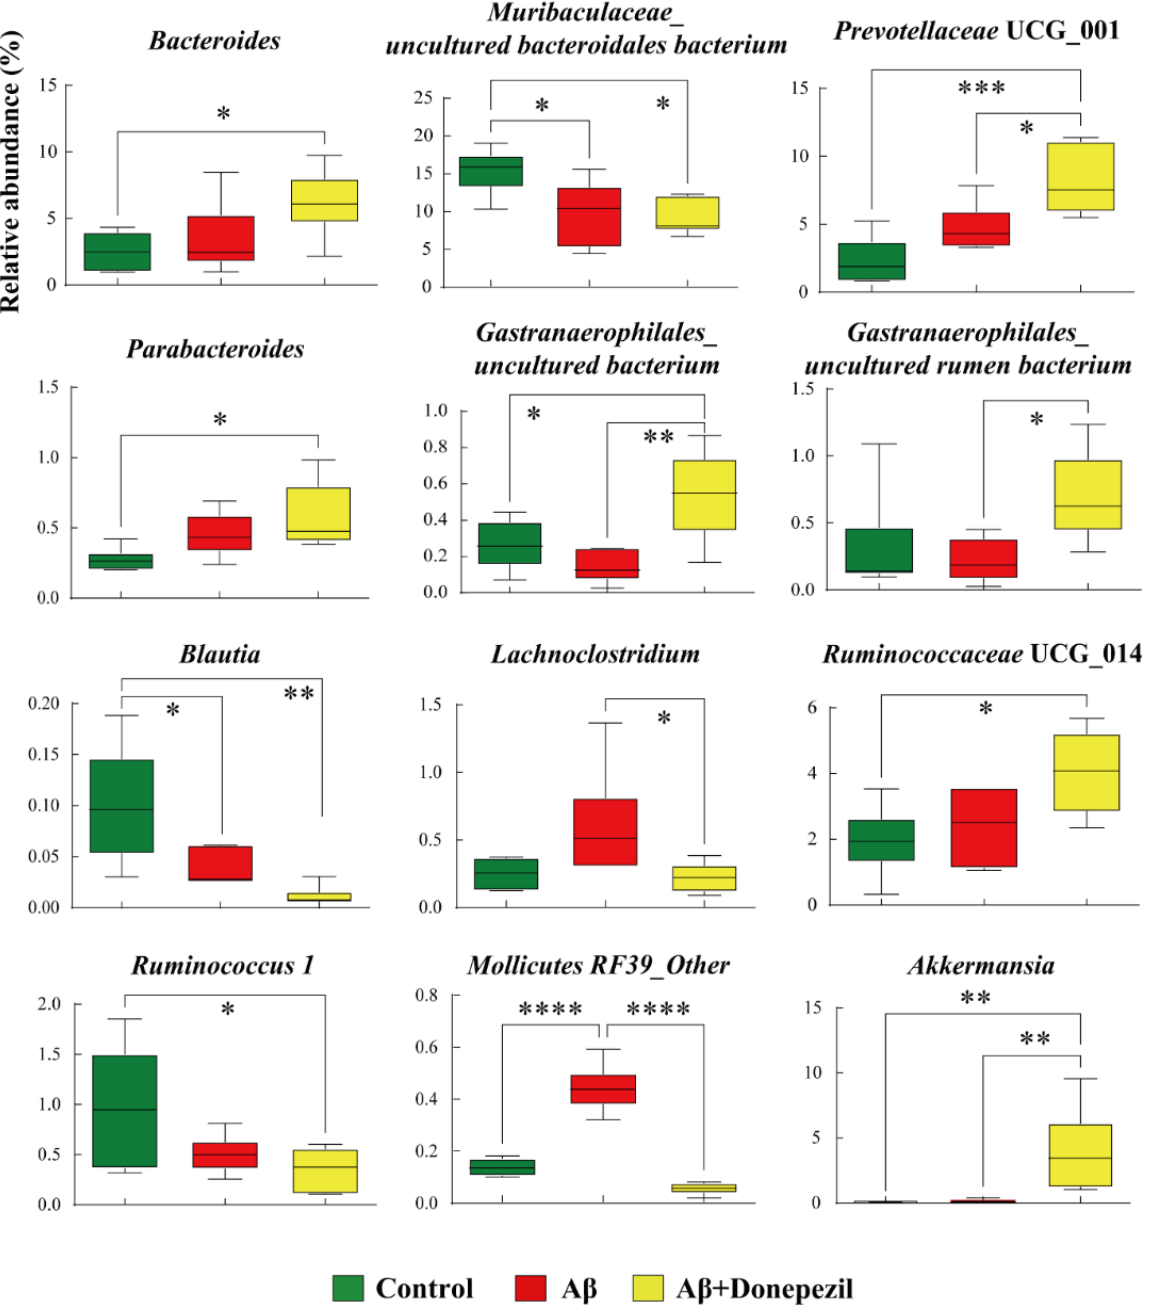
Figure 3. Box plots of significantly different microorganisms at the genus level in the feces of the control, Aβ, and Aβ + donepezil groups. The p values were obtained using one-way analysis of variance (ANOVA) with Tukey’s posthoc test for differences between groups; *, p < 0.05; **, p < 0.01; ***, p < 0.001; ****, p < 0.0001. A false discovery rate (FDR) of 5% was applied to all tests to correct for multiple testing.